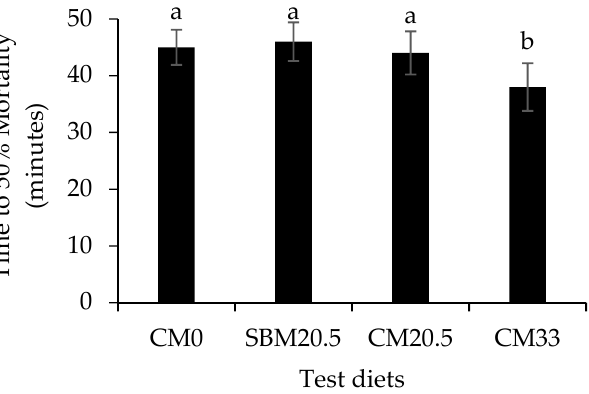
Figure 3. LT 50 (min) was obtained from the onset of mortality time of red sea bream exposed to freshwater. (%, mean ± standard error, n = 3) of nutrients in red seabream fed diets formulated by replacing fish meal with camelina meal at 0% for reference diet (CM0), 20.5 g/kg with soybean mean (SBM20.5), 20.5 g/kg with camelina meal (CM20.5), and 33 g/kg camelina meal (CM33). Values with different letters are significantly different ( p < 0.05). Values with different letters are significantly different ( p < 0.05).